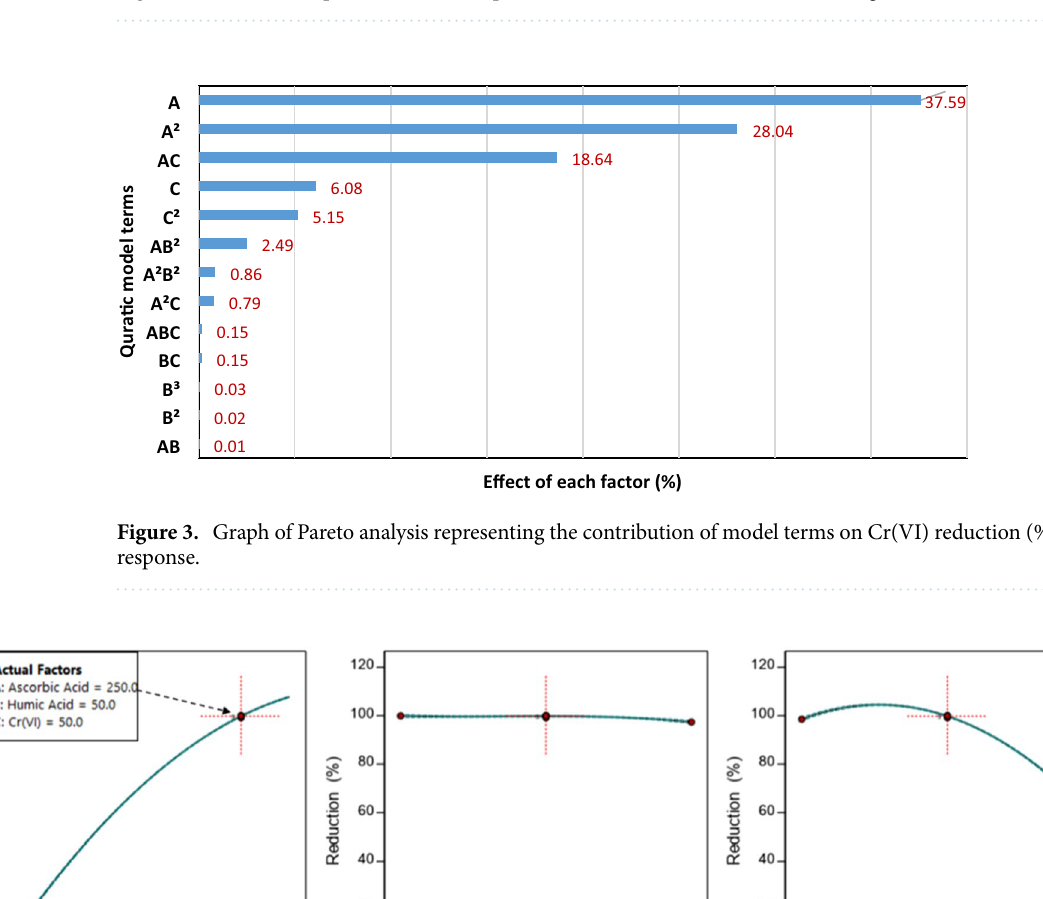
Figure 2. RSM model predicted versus experimental Cr(VI) reduction in water using ascorbic acid.